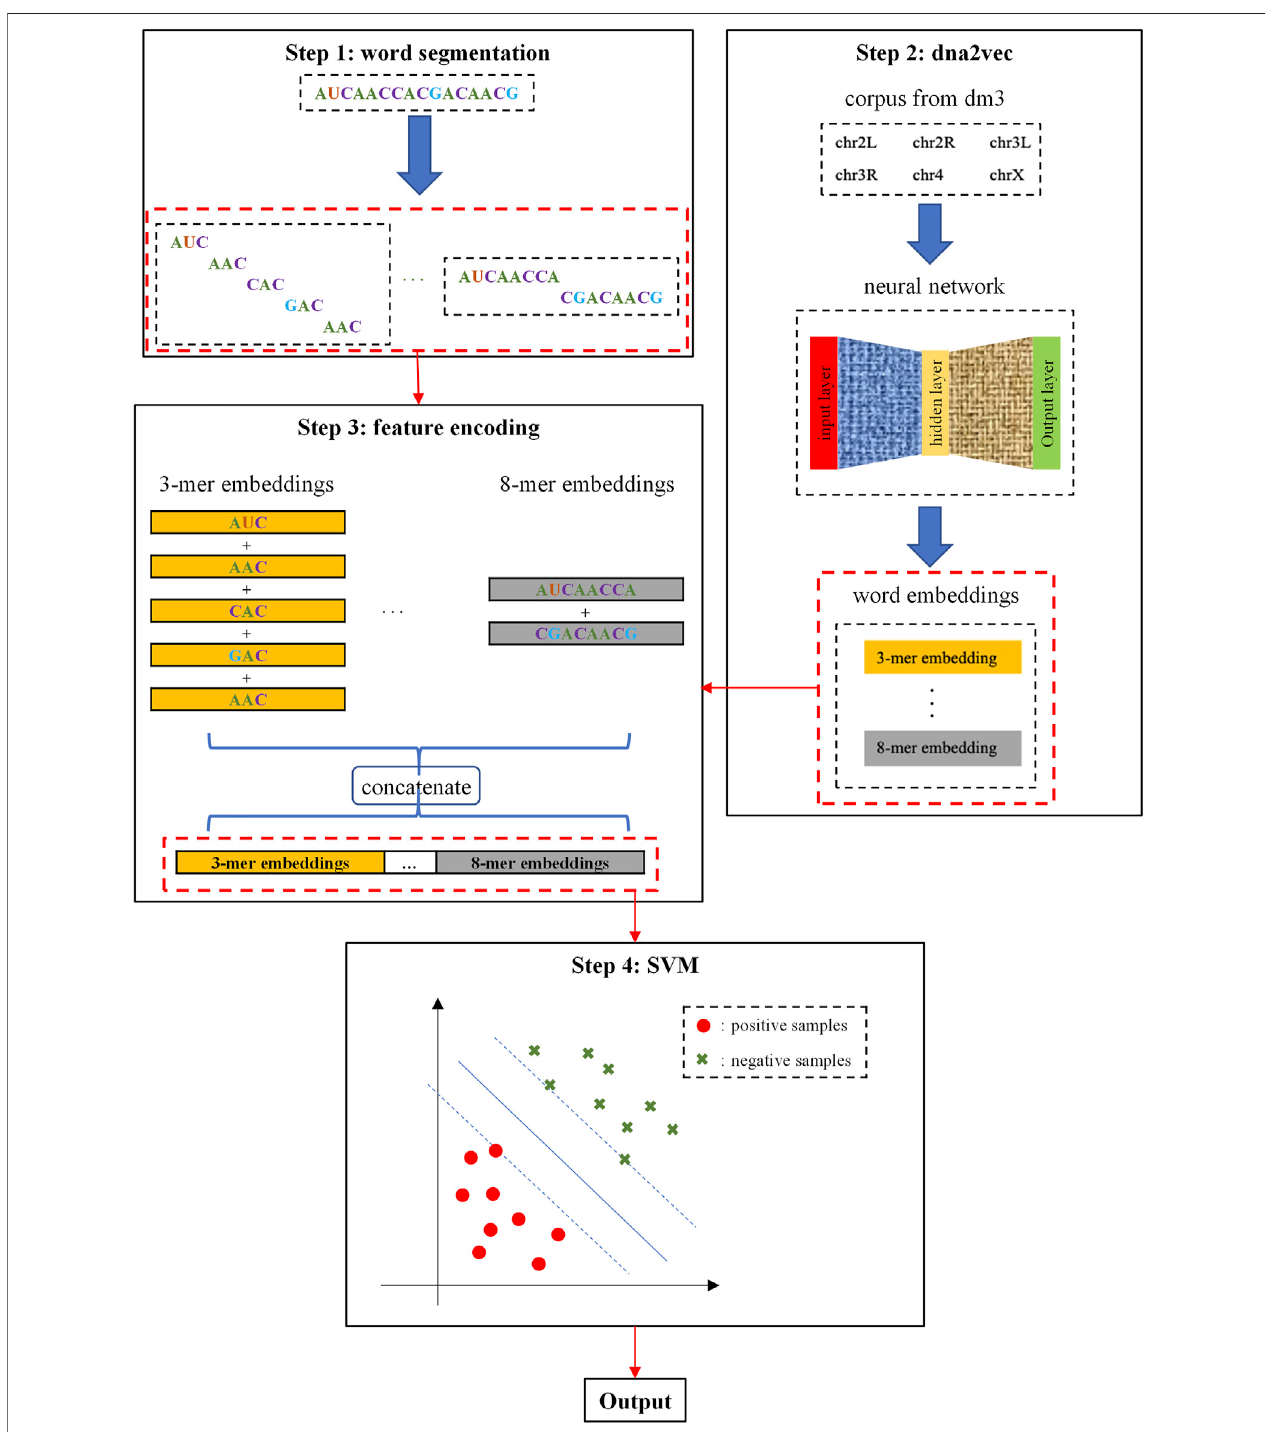
FIGURE 2 | Flowchart of this study. Step 1: RNA sequences are segmented into k -mers in the overlapping way, where k = 3, 4, 5, 6, 7, 8. Step 2: k -mers embeddings were trained by the dna2vec model with corpus from dm3. Step 3: We perform summation and concatenation on these k -mers embeddings to encode RNA sequences. Step 4: SVM is used as a classi fi er for distinguishing positive and negative samples.